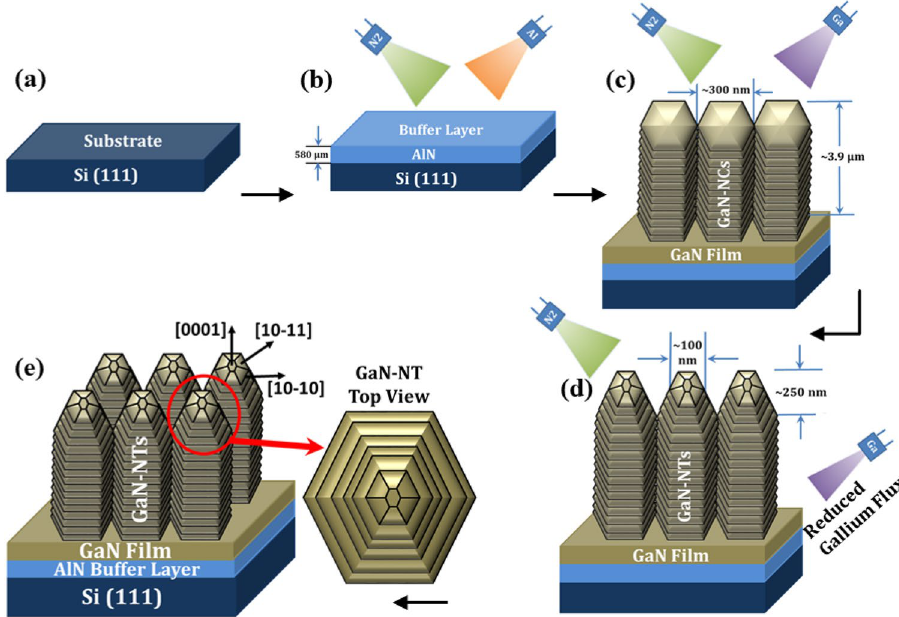
Figure 1. ( a – e ) A schematic growth diagram showing the growth of GaN NTs on Si (111) substrate with sandwitched AlN buffer layer in